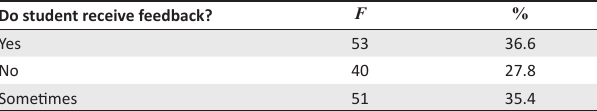
TABLE 4: Do students receive feedback?